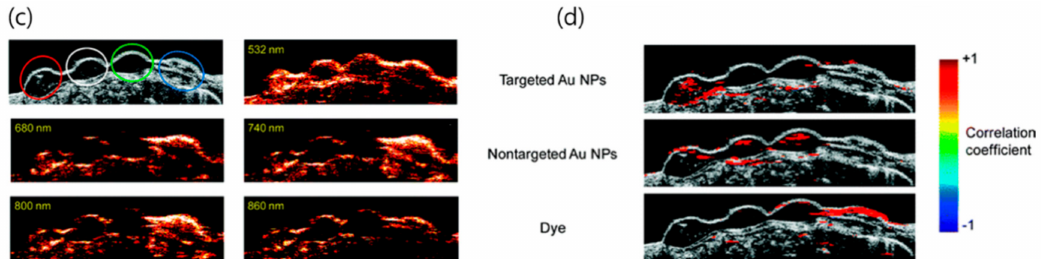
Figure 5. Multiwavelength PAI to tumor-mimicking gelatin implants on ex vivo mouse tissue. ( a ) Photograph of the gelatin implants in mouse tissue. Red, white, green, and blue circles indicate cells with targeted AuNPs, control A431 cells, A431 cells with mPEG-SH coated AuNPs, and NIR dye, respectively. Schematic diagram represents the gelatin two-layer model laden with cells; ( b ) Photoacoustic signal amplitude changes according to the AuNP concentration; ( c ) Ultrasound and photoacoustic images of gelatin implants at di ff erent laser wavelength. Implants with antibody labeled AuNPs (red circle) exhibited greater photoacoustic signals than the other implants; ( d ) Correlation coe ffi cient measured by merged ultrasound and photoacoustic images. Measured correlation coe ffi cient was high in implants with antibody labeled AuNPs. Reproduced from